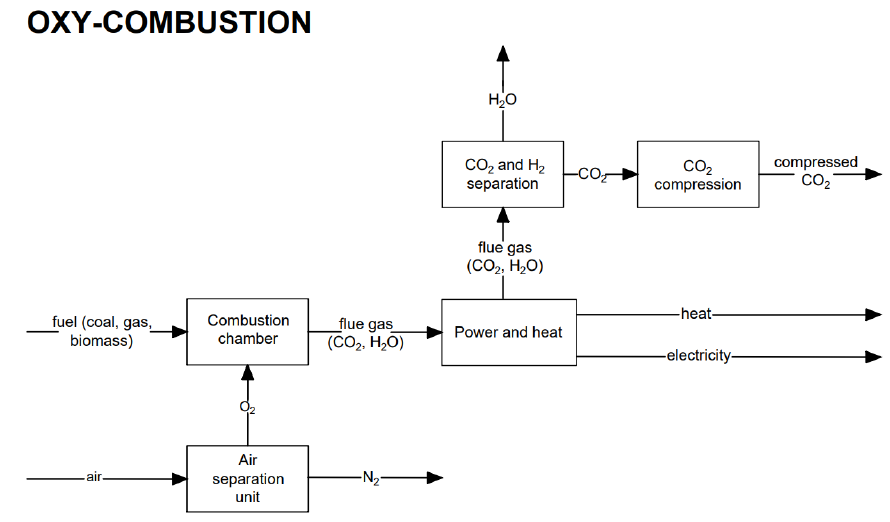
Figure 9. Block diagram of electricity generation heat production with the oxy-combustion CO 2 capture method.